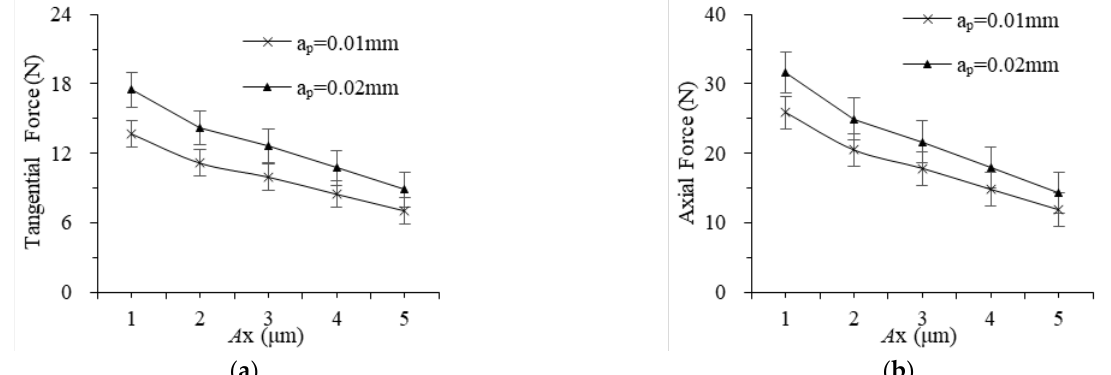
Figure 6. The effect of workpiece vibration amplitude on grinding force: ( a ) tangential and ( b ) axial.